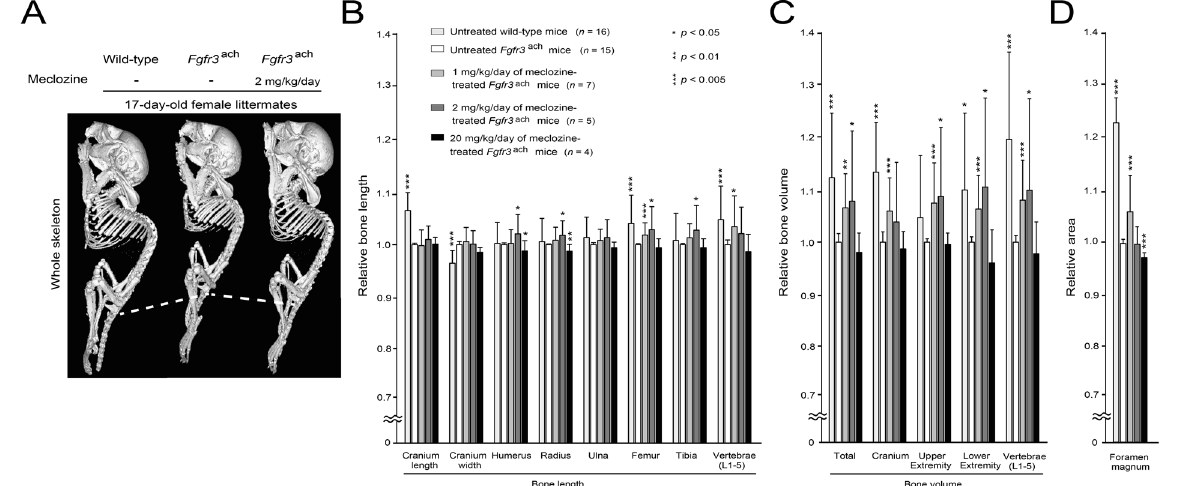
Figure 3. Quantitative 3D-CT examinations reveal increased bone length and bone volume of long tubular bones and vertebrae in meclozine-treated Fgfr3 ach mice. ( A ) A representative reconstructed micro-CT image of the individual female littermates at the end of treatment showed that the body length was increased by twice- daily administration of 2 mg/kg/day of meclozine. Dotted lines indicate the inferior margin of the ischium. ( B ) Relative bone lengths of long tubular bones and vertebrae were increased after twice-daily administration of 1 or 2 mg/kg/day of meclozine. ( C ) Relative bone volumes of the cranium, upper and lower extremities, and vertebrae were significantly increased after meclozine treatment. ( D ) Only 1 mg/kg/day of meclozine enhanced the areas of foramen magnum, which did not chang by 2 mg/kg/day of meclozine treatment. Relative length, volume, and area were calculated based on those of untreated Fgfr3 ach mice. Mean and SD are indicated. Statistical significance was analyzed by the unpaired t test for each dose of meclozine-treated Fgfr3 ach mice ( n = 7, 5, and 4 for 1, 2, and 20 mg/kg/day of meclozine, respectively) or untreated wild-type mice ( n = 18) versus untreated Fgfr3 ach mice ( n =